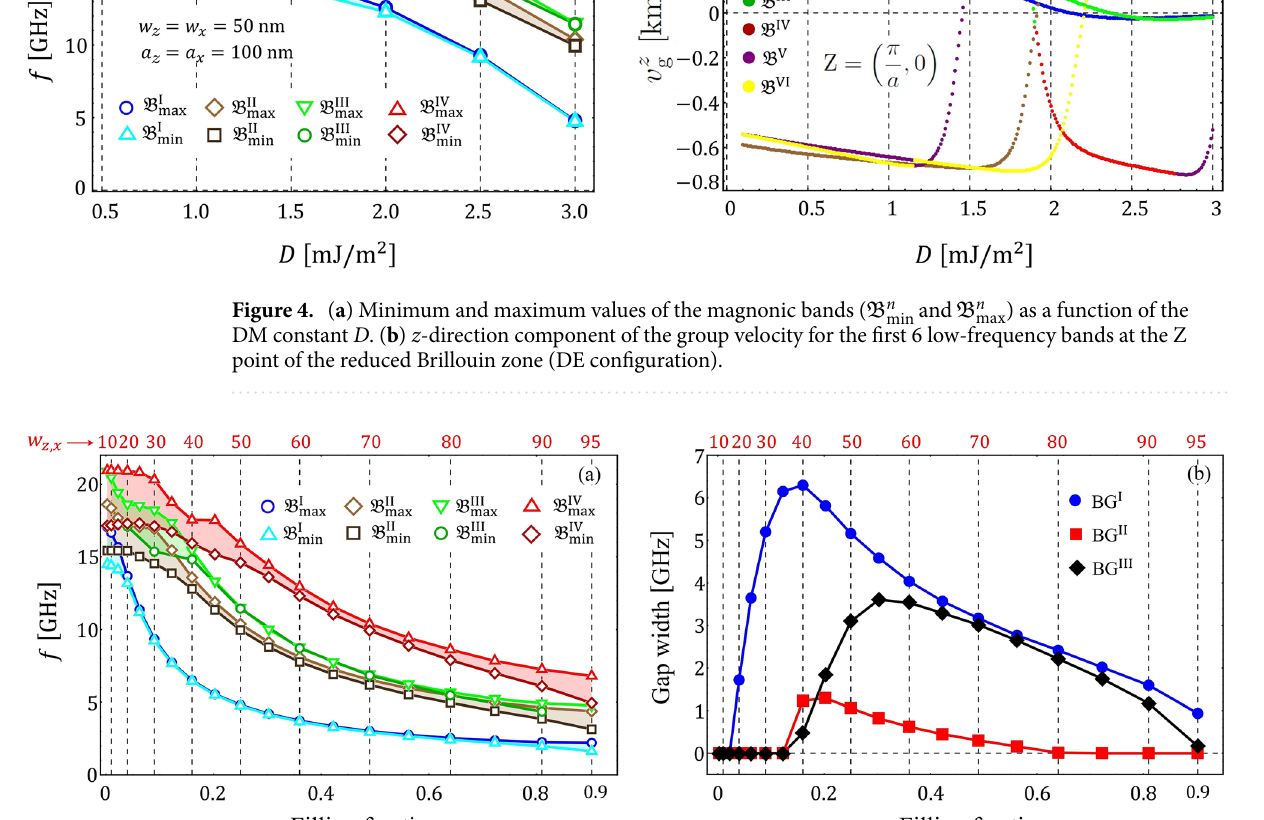
( π/ a z , 0 ) for given values of D . In the case of the BV configuration, the group velocity v x g is about 3 orders of magnitude smaller than v z g (not shown), and v x g tends to reach magnitudes close to zero for lower values of the constant D as compared with DE modes. The SW propagation for the DE and BV configurations is studied in the reduced Brillouin zone, where the magnitude of the DMI constant D is first varied while keeping the geometric parameters of the MC fixed. Another phenomenon worth analyzing is observing how the band structure is modified while altering the geo- metric parameters. In Fig. 5, the DM constant is kept fixed ( D = 3 mJ/m 2 ), while the lateral dimensions of the heavy-metal square islands are varied. Figure 5a depicts square islands with w x = w z in the range 10 − 95 nm, where the period is kept fixed at a x = a z = 100 nm. In Fig. 5a, the minimum and maximum frequencies of the bands ( B n min and B n max ) are calculated, for the first four bands, as a function of the filling fraction ( w x w z / a x a z ), which represents the portion of the ferromagnetic film covered with the heavy metal. The filling fraction plays an essential role in creating flat bands and bandgap widths. For the first band B I , from w z , x = 30 nm to 80 nm (or filling fraction from 0.09 to 0.64) the bands become flat. The third band B III become flat from approximately w z , x = 50 nm to 80 nm (filling fraction between 0.25 and 0.64). For the bands B II and B IV , there is no flat band observed for D = 3 mJ/m 2 . On the other side, the bandgap widths (defined by the difference B n + 1 min − B n max ) are shown in Fig. 5b as function of the filling fraction and the square width (upper red scale). One can also note that the first and third bandgap widths reach a significant maximum compared to the second BG width. This behavior also occurs for low values of D but with reduced bandgap widths. In addition, the maximum of the first and second BG widths is reached at similar values of the island widths ( w z , x ), while the third BG width occurs at a slightly larger w z , x .